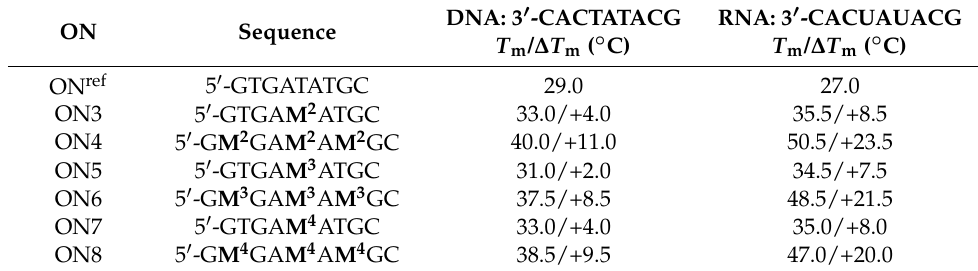
Table 1. Thermal denaturation temperatures of matched duplexes (DNA/DNA and DNA /RNA) a . DNA: 3 (cid:48) -CACTATACG RNA: 3 (cid:48) -CACUAUACG ON Sequence T m / ∆ T m ( ◦ C) T m / ∆ T m ( ◦ C) ON ref 5 (cid:48) -GTGATATGC 29.0 27.0 ON3 5 (cid:48) -GTGA M 2 ATGC 33.0/+4.0 35.5/+8.5 ON4 5 (cid:48) -G M 2 GA M 2 A M 2 GC 40.0/+11.0 50.5/+23.5 ON5 31.0/+2.0